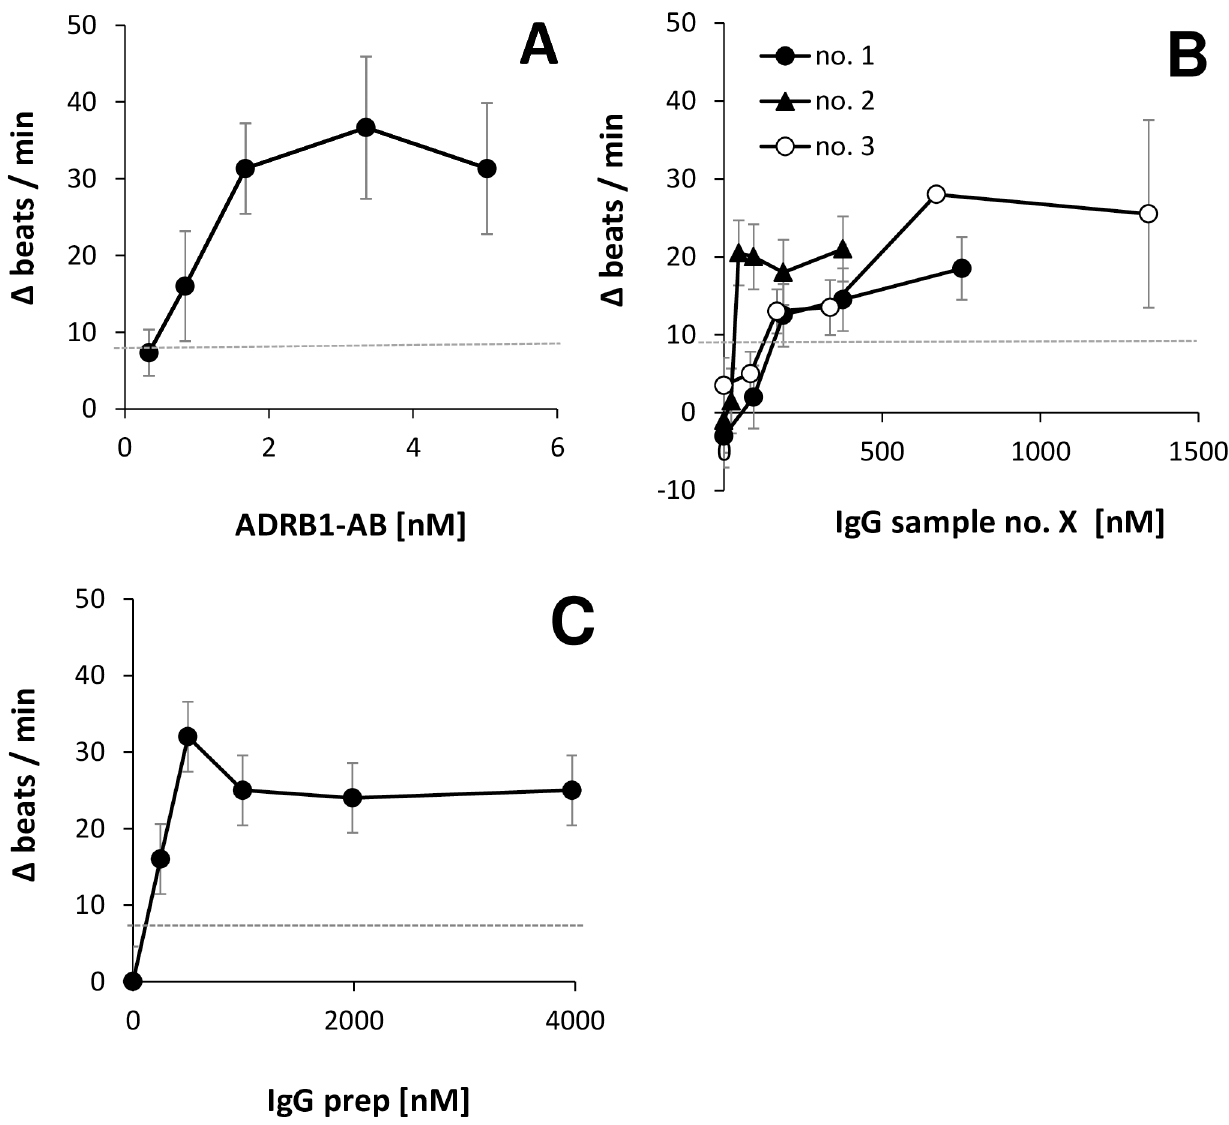
Fig 7. Concentration-effectivity relationship. Increases in the chronotropic activity of neonatal rat cardiomyocytes caused by increasing concentration of A: ADRB1-AB (data are the mean of six technical replicates) and B: IgG preparation of human samples no. 1–3 (two independent flasks each, measured in four technical replicates each) and C: of a non-enriched IgG preparation (n = 1, 4 technical replicates). The dotted line at 8 Δ beats/min marks the cut- off between beta1-AAB positivity and negativity.